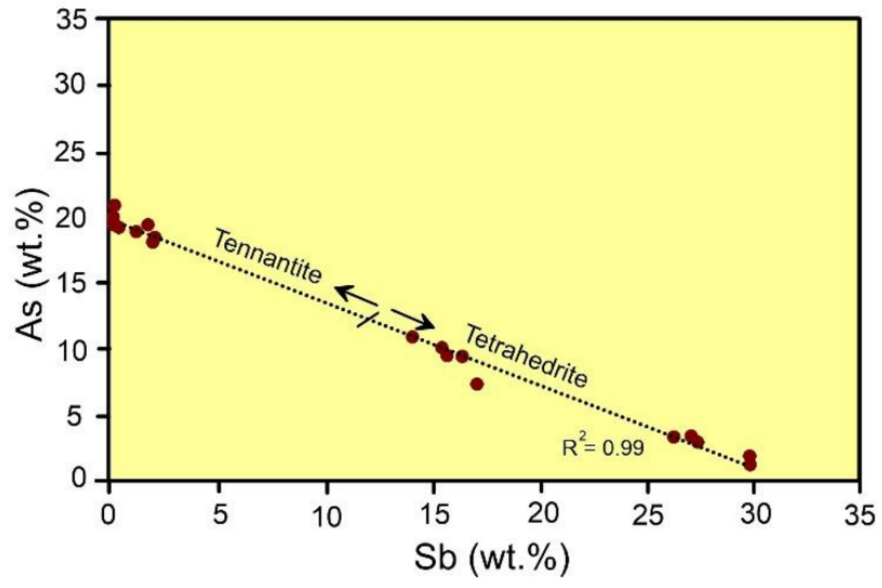
Figure 15. Chemical variations of As versus Sb in tetrahedrite-tennantite series.